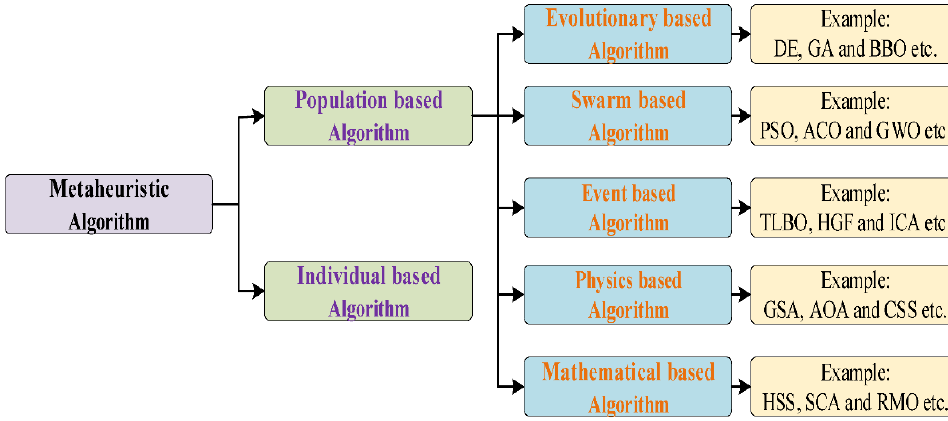
Figure 4. Classification of metaheuristic